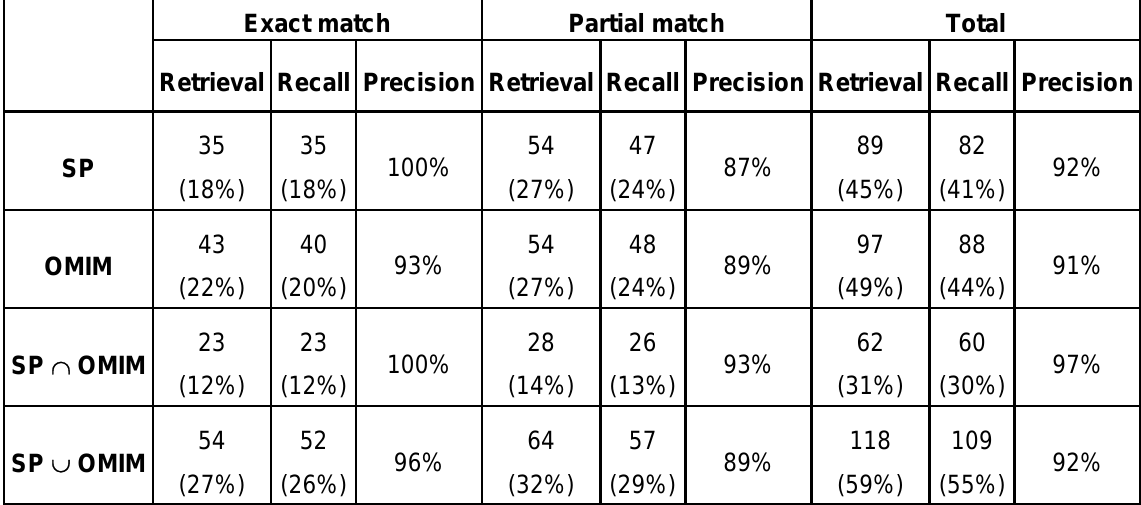
Table 1: Result of the mapping of 200 disease comment lines from Swiss-Prot on MeSH terms. SP ∩ OMIM means that both mappings correspond to the same MeSH descriptor. Exact match Partial match